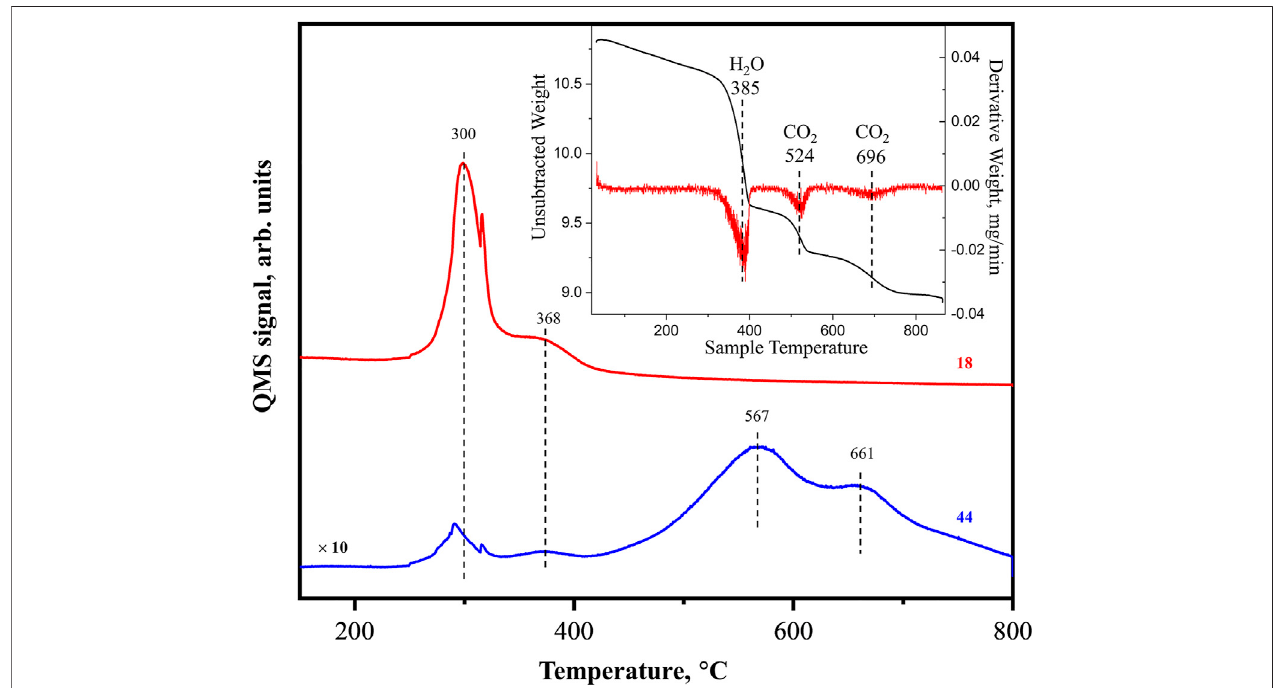
FIGURE 2 | MS data of as-prepared La 2 O 3 sample heated from room temperature to 800 ° C, showing the desorption signal of H 2 O (amu (amu (cid:1) 44). Inset: Thermogravimetric analysis (TGA) weight loss curve of La 2 O 3 sample under N 2 fl ow (black) and derivative (red) from Li et al. (2019).